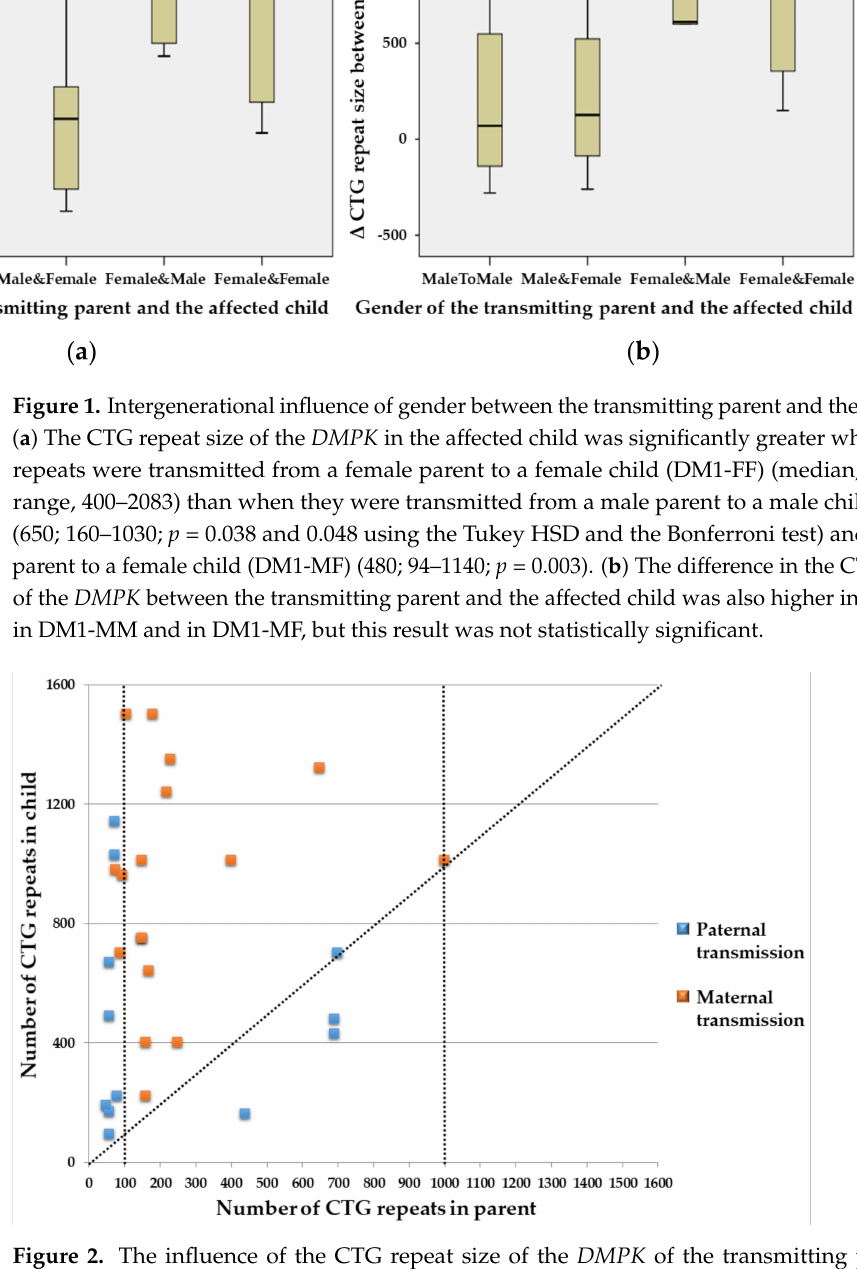
Figure 2. The influence of the CTG repeat size of the DMPK of the transmitting parent on the affected child. CTG repeat reduction or no expansion only occurred following paternal transmission, even though the transmitting father and the affected child were diagnosed as having classic DM1. The vertical dotted line is used to indicate the mild (CTG repeat size with 50–100 repeats), classic (100–1000), and congenital (>1000) DM1 phenotypes. The diagonal dotted line indicates the influence of the CTG repeat size of the DMPK of the transmitting parent on that of the affected